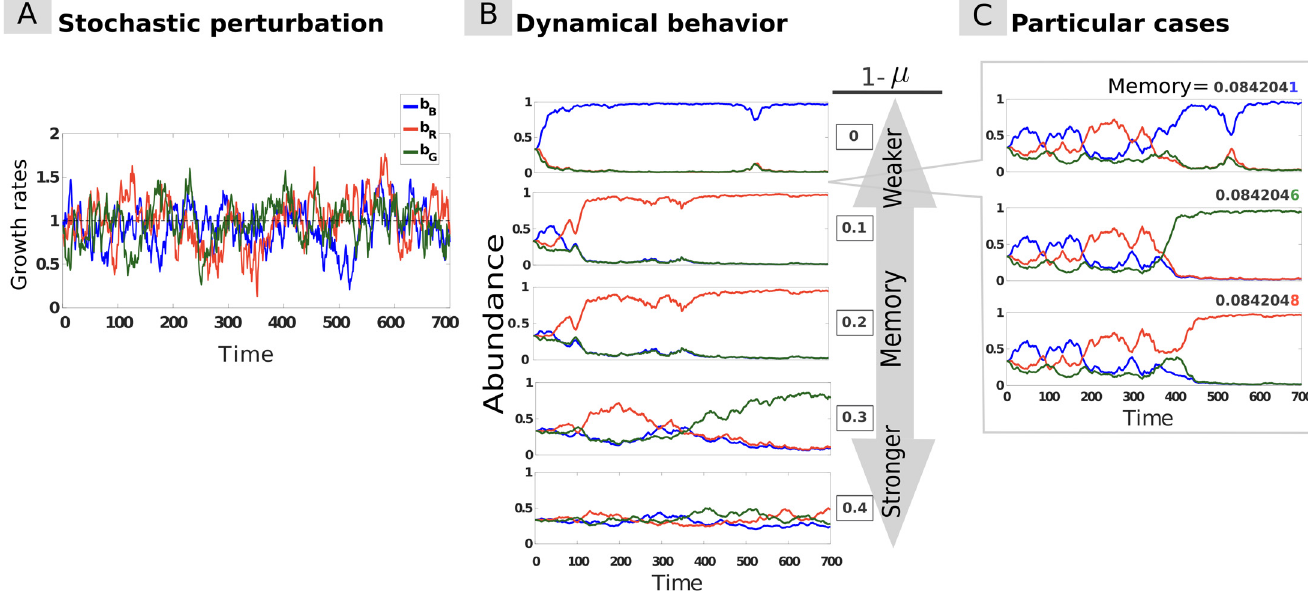
Fig 4. Stochastic perturbations with commensurate memory effects. (A) Species growth rates b i vary stochastically through time according to an Ornstein- Uhlenbeck process (see Table in S1 Table). (B) Dynamical behavior of the system in response to the stochastic perturbation for equal initial species abundances and varying memory level: in addition to slowing down community dynamics, increasing memory limits the overall variation in species abundances, thus enhancing the overall resistance of the system and promoting species coexistence. (C) For some memory strengths, the final state of the system can be sensitive to slight variations in memory, with drastic consequences on community